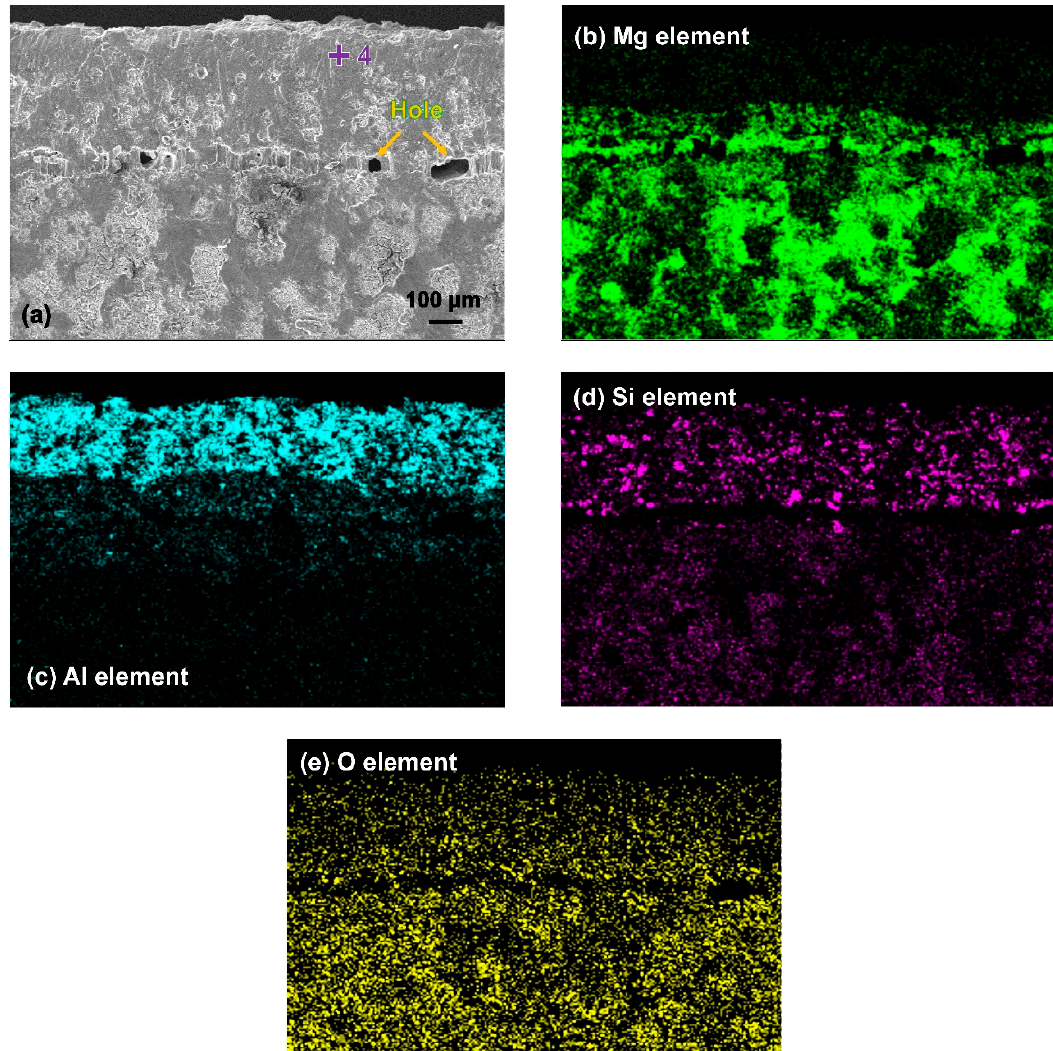
Figure 13. ( a ) Cross-sectional SEM micrographs and ( b – e ) the corresponding elemental mappings (Mg, Al, Si and O K α ) of the damaged Comps2 coating after 240 thermal cycles in condition II.